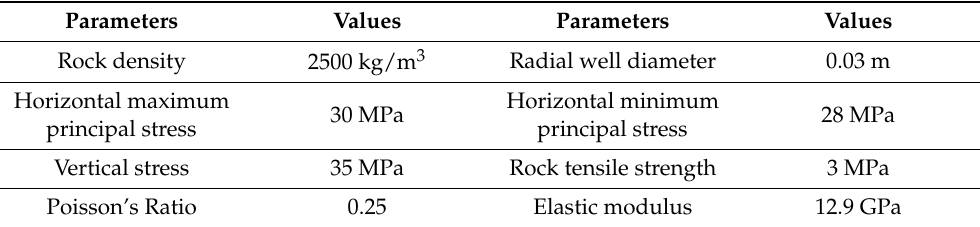
Table 1. Reservoir parameters.